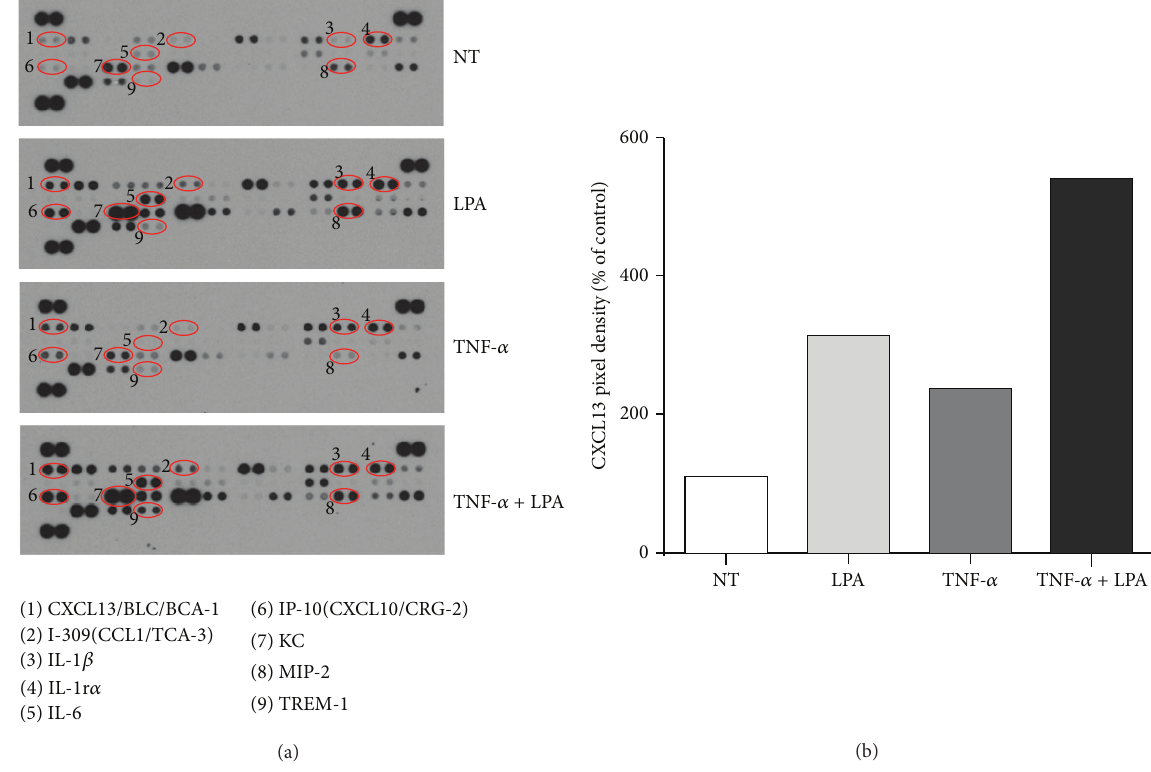
Figure 1: Effect of LPA on CXCL13 secretion in the murine air pouch with or without TNF- 𝛼 pretreatment. (a) Six-day-old air pouches were produced in the dorsal skin of mice and injected with TNF- 𝛼 or the vehicle for 16h prior to stimulation with LPA for 2 h. The nontreated (NT) group was injected with vehicle only (PBS-BSA). The air pouch exudates ( 𝑛 = 3 ) were collected and pooled for qualitative analysis of cytokine/chemokine secretion using the Proteome Profiler Mouse Antibody Array Panel (a). (b) Normalized data representing CXCL13 pixel density are the mean from two independent